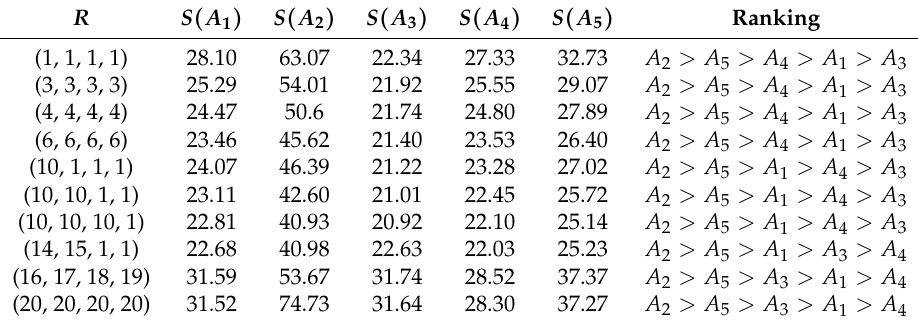
Table 8. Ranking for different parameters of